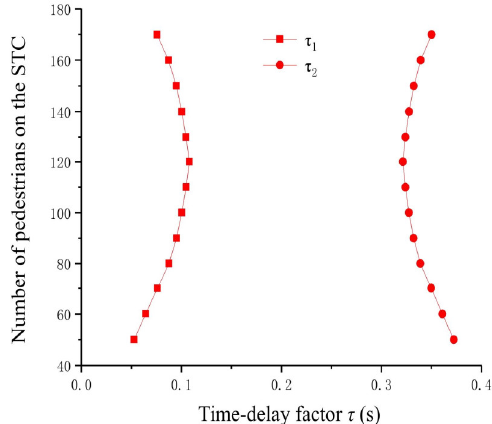
Figure 5. Bifurcation diagram of time-delay effect and pedestrians number on the STC.